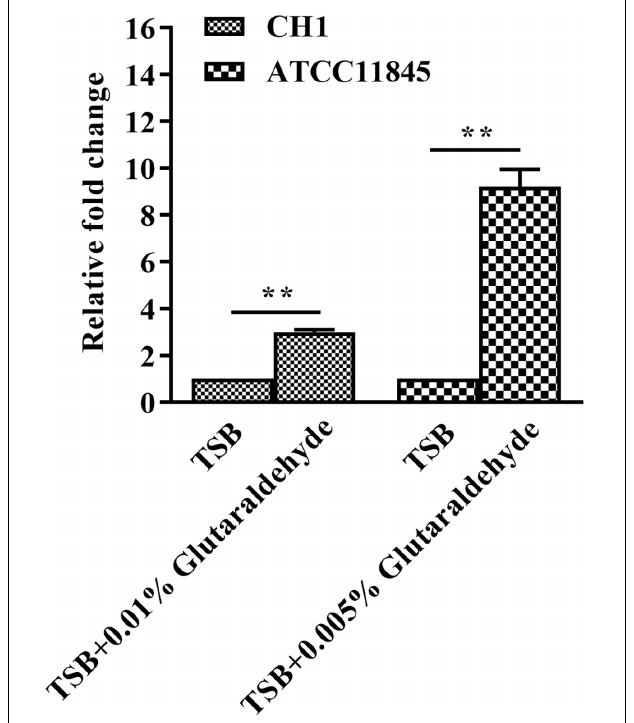
FIGURE 2 | Changes in lptD transcription in R. anatipestifer CH-1 and ATCC11845 in TSB and TSB with glutaraldehyde. qRT-PCR analysis of the relative expression of lptD in strain CH-1 and strain ATCC11845 in TSB and TSB with glutaraldehyde (0.01% (vol/vol) and 0.005% (vol/vol) for strain CH-1 and strain ATCC11845, respectively).The data were analyzed using Student’s t -test. The error bars represent the standard deviations of three independent experiments, ∗∗ , p <